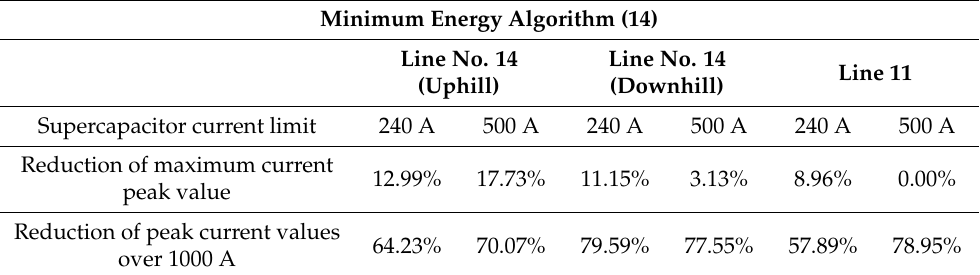
Table 3. Comparison of percentage reduction of current peak values using the minimum energy algorithm and without algorithm.